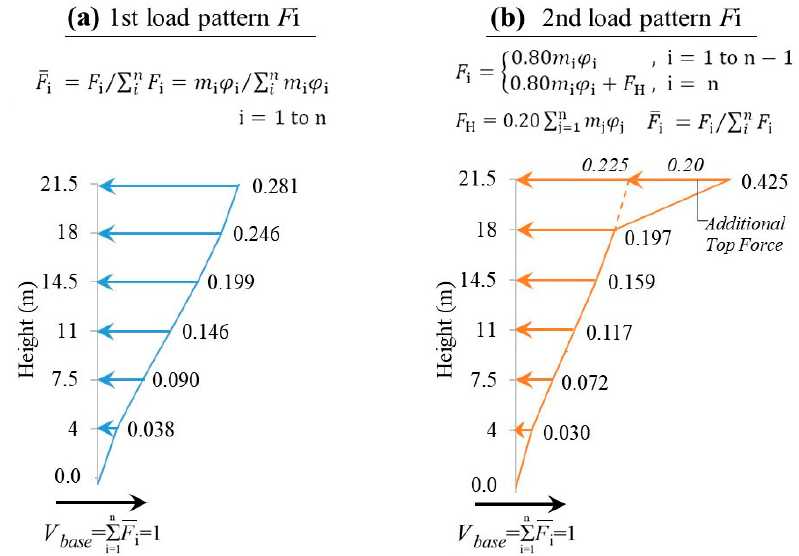
Figure 8. Two different in elevation loading patterns: ( a ) proportional to the fundamental uncoupled translational modes along I sec and II sec axis for a base shear equal to 1 kN, ( b ) similar to the first but for 80% of the unit base shear and the remainder 20% is applied as an additional lateral force at the building top.